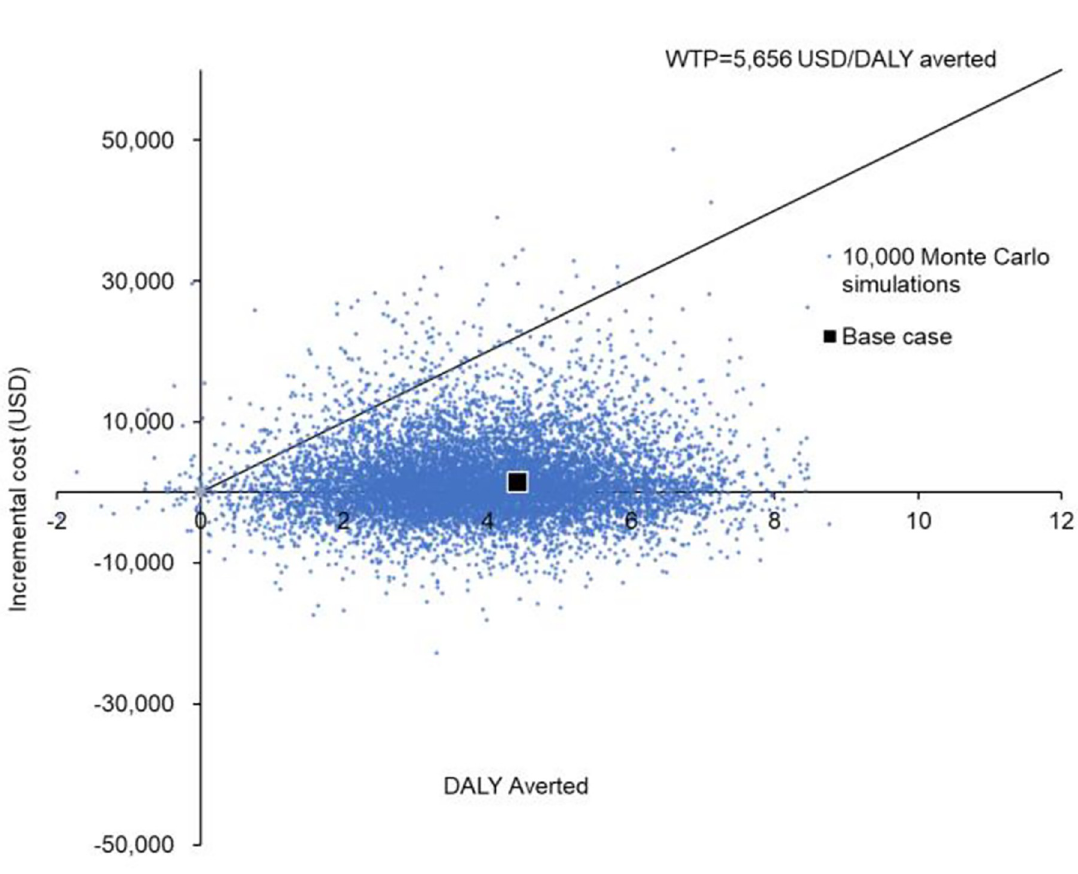
Fig 3. Scatter plot of the incremental cost against DALY averted by the BDQ group versus the conventional group in 10,000 Monte-Carlo simulations. BDQ: Bedaquiline; DALY: Disability-adjusted life-year; WTP: Willingness-to-pay.